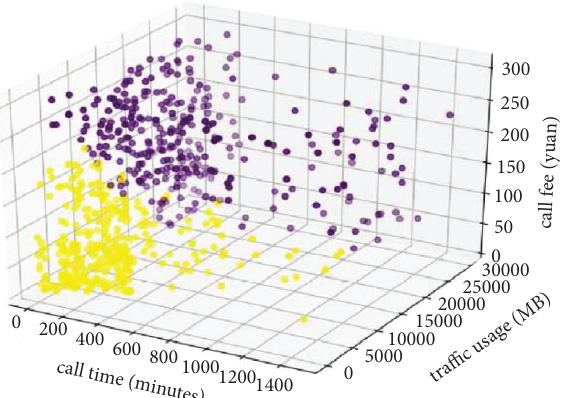
Figure 7: Clustering analysis of user traffic flow: k � 5.